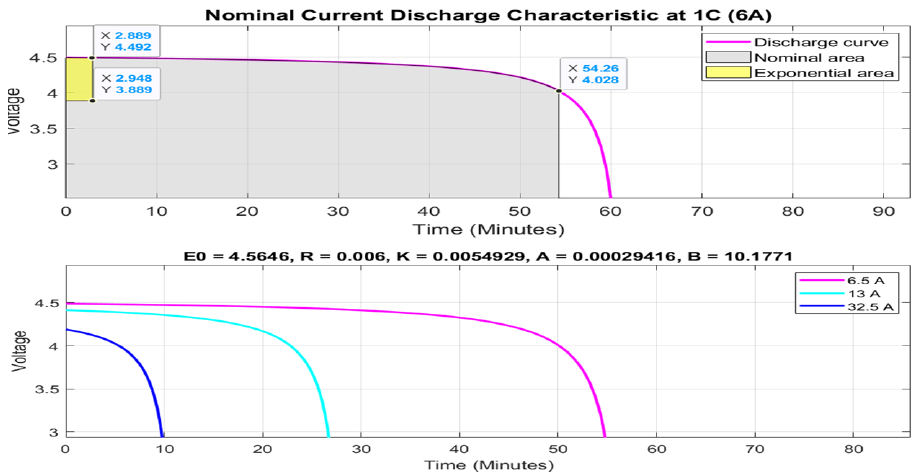
Figure 17. SAFT Li-ion battery nominal current discharge characteristic @1C (6A) (top side view); @6.5A, 13A and 32.5A (bottom view)—Simscape non-linear model (x-scale is the time in minutes).